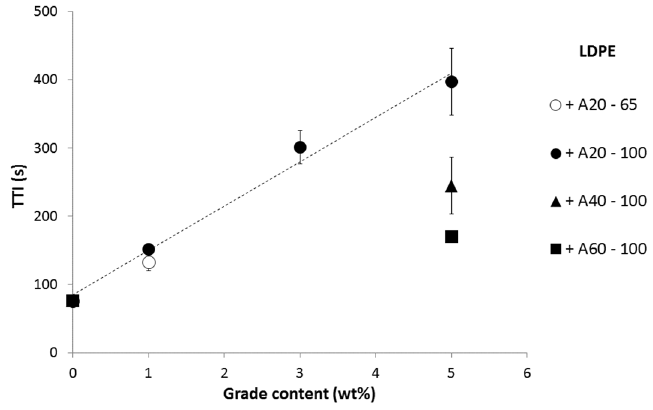
Figure 8. Time ‐ to ‐ ignition (s) versus grade content in the coating at 35 kW/m 2 .